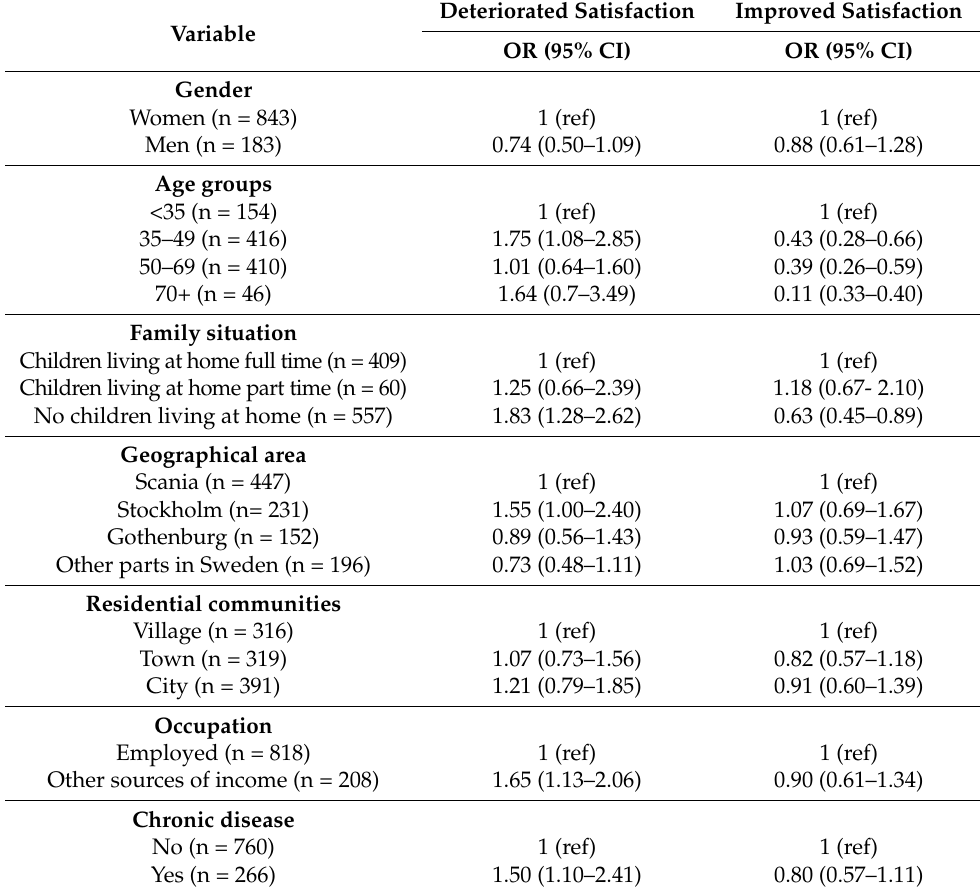
Table 5. Odds ratio for deteriorated and improved satisfaction with life as a whole, OR (95% CI). Deteriorated Variable